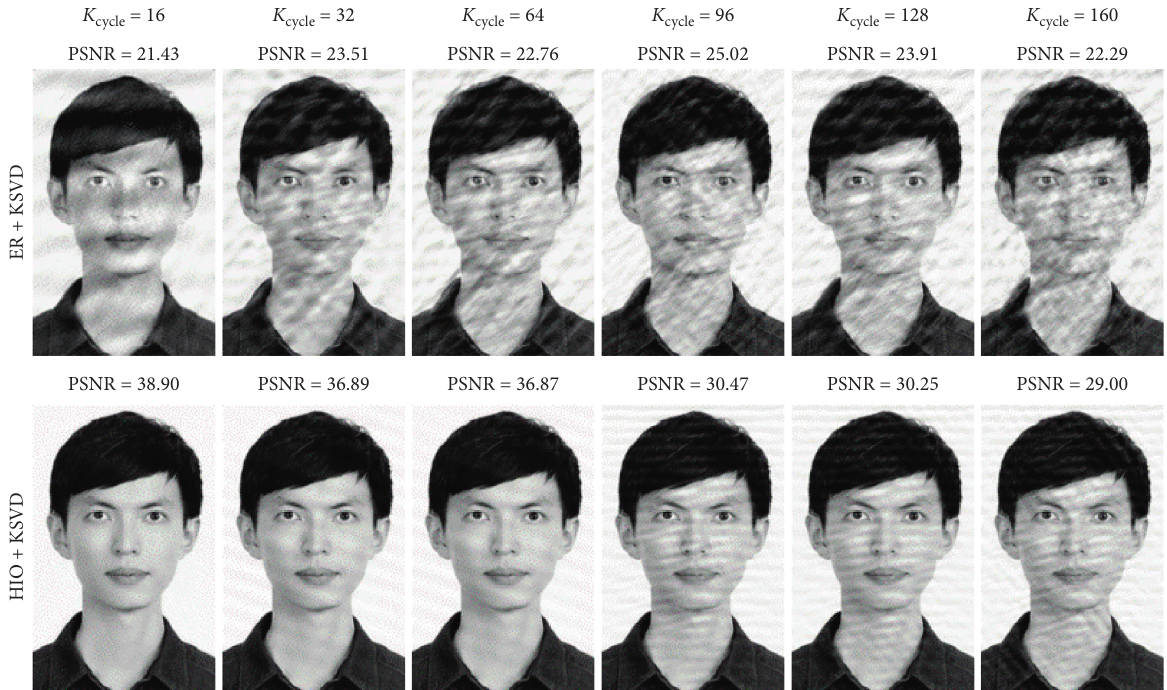
Figure 11: Comparison of reconstructed objects with different iteration cycles ( K � 800. Here, the objects were reconstructed from the noise-free diffraction intensity and all of the cases were of PR iterations was set to K MAX under the same initial Fourier phases.